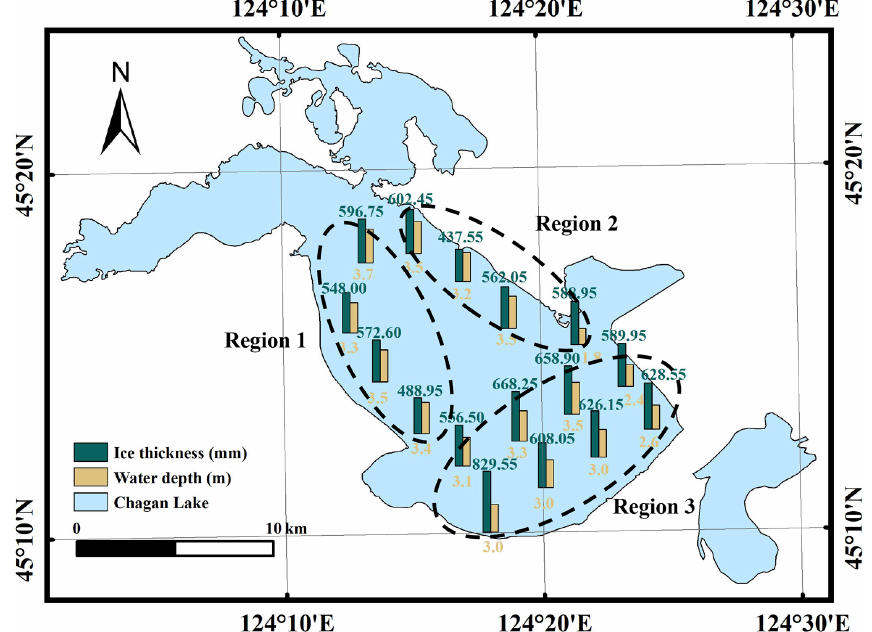
Figure 7. The ice thickness (mm) and water depth (m) of Chagan Lake was measured during the periods from 2 to 4 January